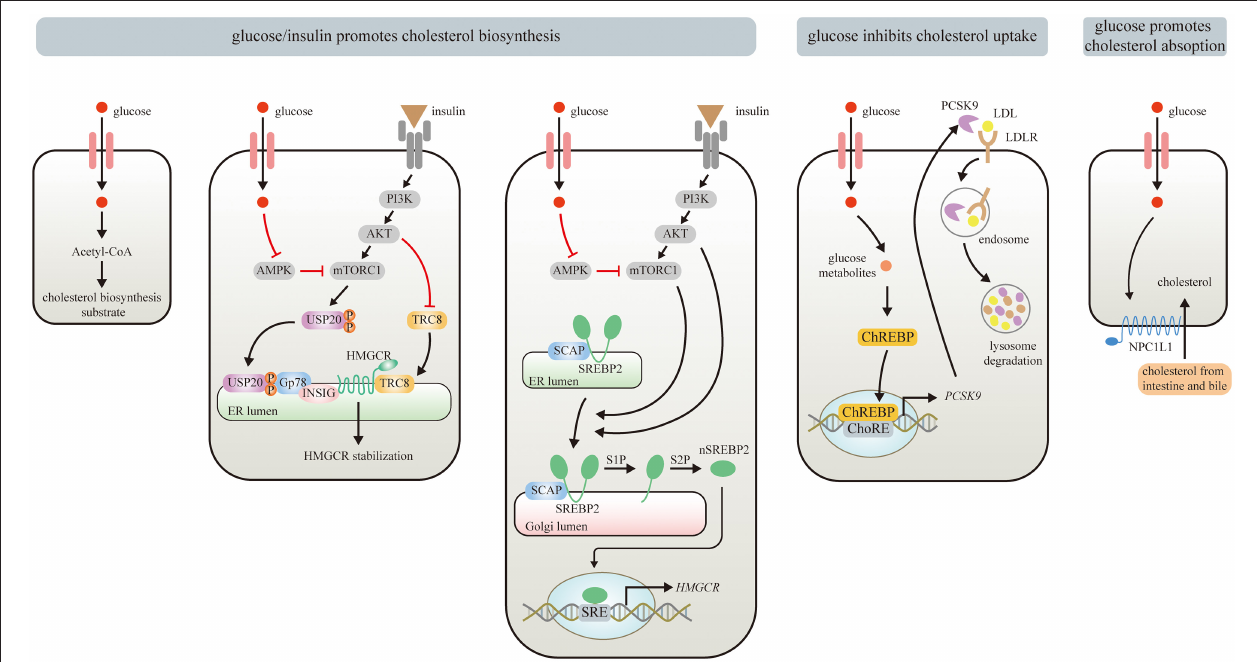
FIGURE 1 | Effects of Glucose/insulin on cholesterol metabolism. Glucose provides Acetyl-CoA for cholesterol biosynthesis. Glucose/insulin also enhances cholesterol biosynthesis by stabilizing HMGCR and increasing HMGCR expression. Glucose or insulin activates mTORC1 by repressing AMPK or stimulating insulin-mediated PI3K/AKT signaling pathway, respectively. The USP20 phosphorylated by mTORC1 prevents HMGCR from being degraded by GP78. PI3K/Akt signaling pathway also stabilizes HMGCR via inhibiting the recruitment of E3 ligase TRC8. The upregulated mTORC1 can promote the translocation of SREBP2 from ER to the Golgi apparatus, where nSREBP2 is produced sequentially by the S1P and S2P. nSREBP2 translocates into the nucleus and binds to SRE sequences to stimulate HMGCR expression. Meanwhile, PI3K/Akt signaling pathway upregulates HMGCR via promoting SREBP–SCAP complex to migrate into the Golgi. Besides, glucose and its metabolites inhibit cholesterol uptake by activating ChREBP, which enters the nucleus to augment human PCSK9 expression, thereby increasing PCSK9-induced LDLR degradation. Moreover, elevated circulating glucose levels can enhance enterocyte NPC1L1 expression via some unknown mechanisms, thereby strengthening intestinal absorption of